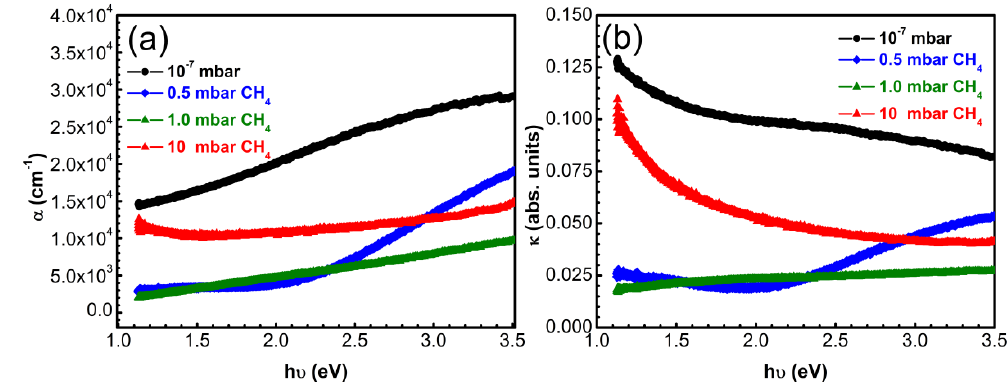
Figure 8. ( a ) Absorption coefficient α and ( b ) extinction coefficient k vs incident photons energy in case of carbon thin films synthesized by PLD in vacuum or CH 4 on bare quartz